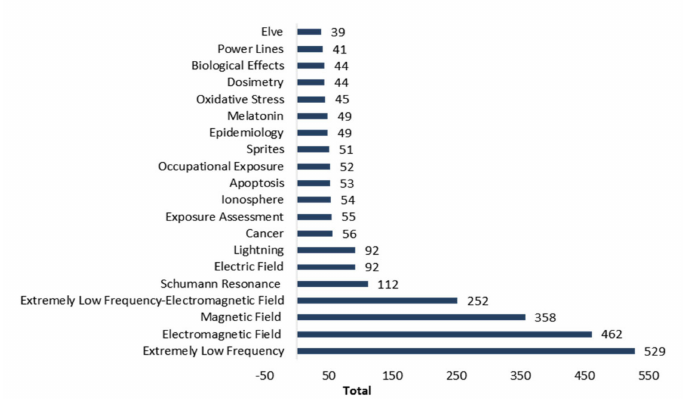
Figure 5. Representation of the 20 most-repeated global keywords.